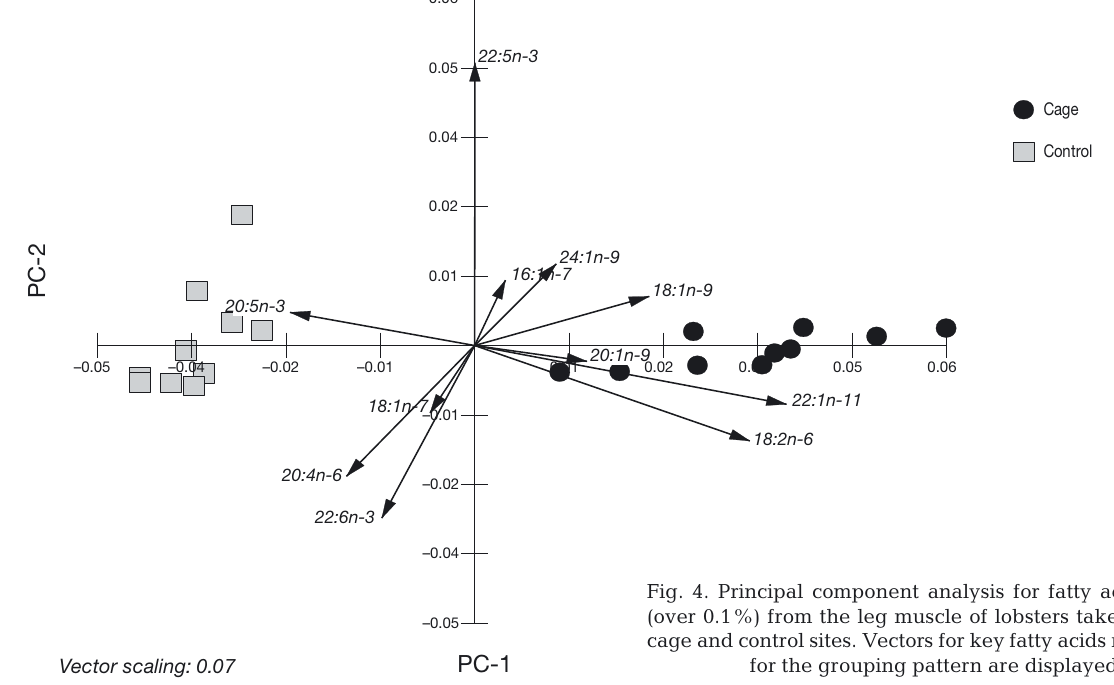
Table 1). Overall, tracer FAs accounted for 29.08% of the total lipid content of the cage station, which was significantly higher when compared to the control station (11.36%). Conversely, total n-3 PUFA levels were significantly higher (p < 0.05) at the control site (43.27 ± 1.38%) compared to the cage site (32.3± 3%). FA s contributing to the difference between the con- trol and the cage site were eicosapentaenoic acid (EPA, 22.8 ± 1% and 14.9 ± 0.9%) and docosa-